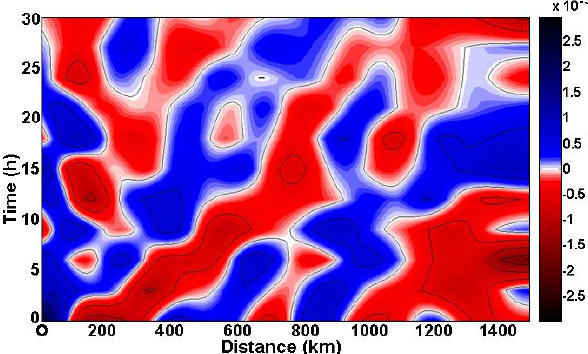
Fig. 13. Hovmöller diagram of longitudinal pressure perturbation at 16 ◦ S from 16 February 2008 at 12:00UTC to 17 February at 18:00UTC at